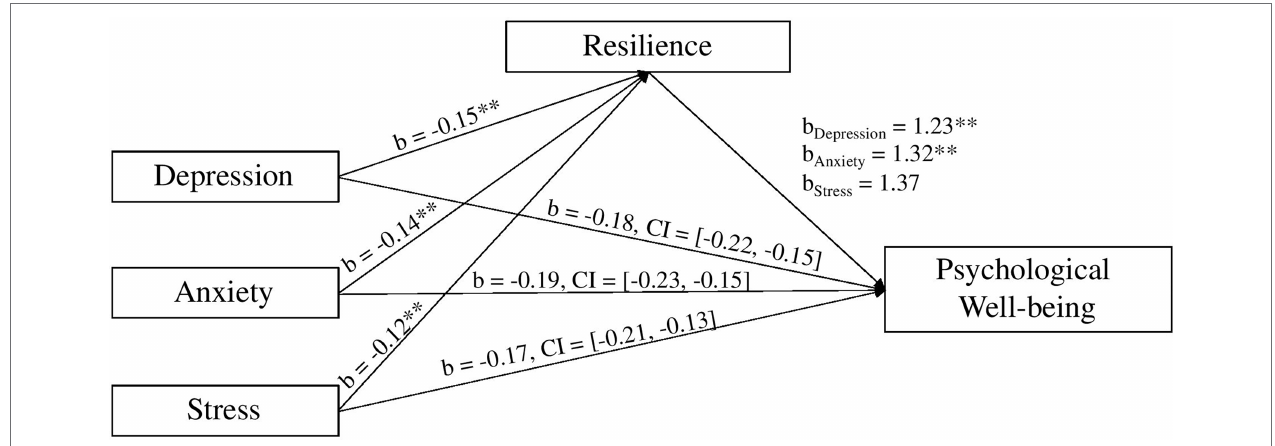
FIGURE 3 | Resilience mediates the effect of the psychological outcomes (depression, anxiety, and stress) on psychological wellbeing. Note: ** p < 0.001.